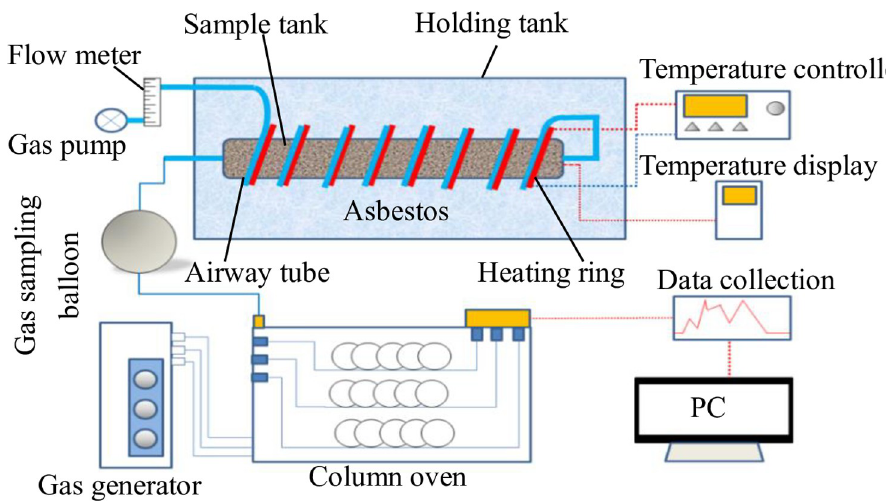
Fig 1. Schematic of the experimental setup for indicator gas